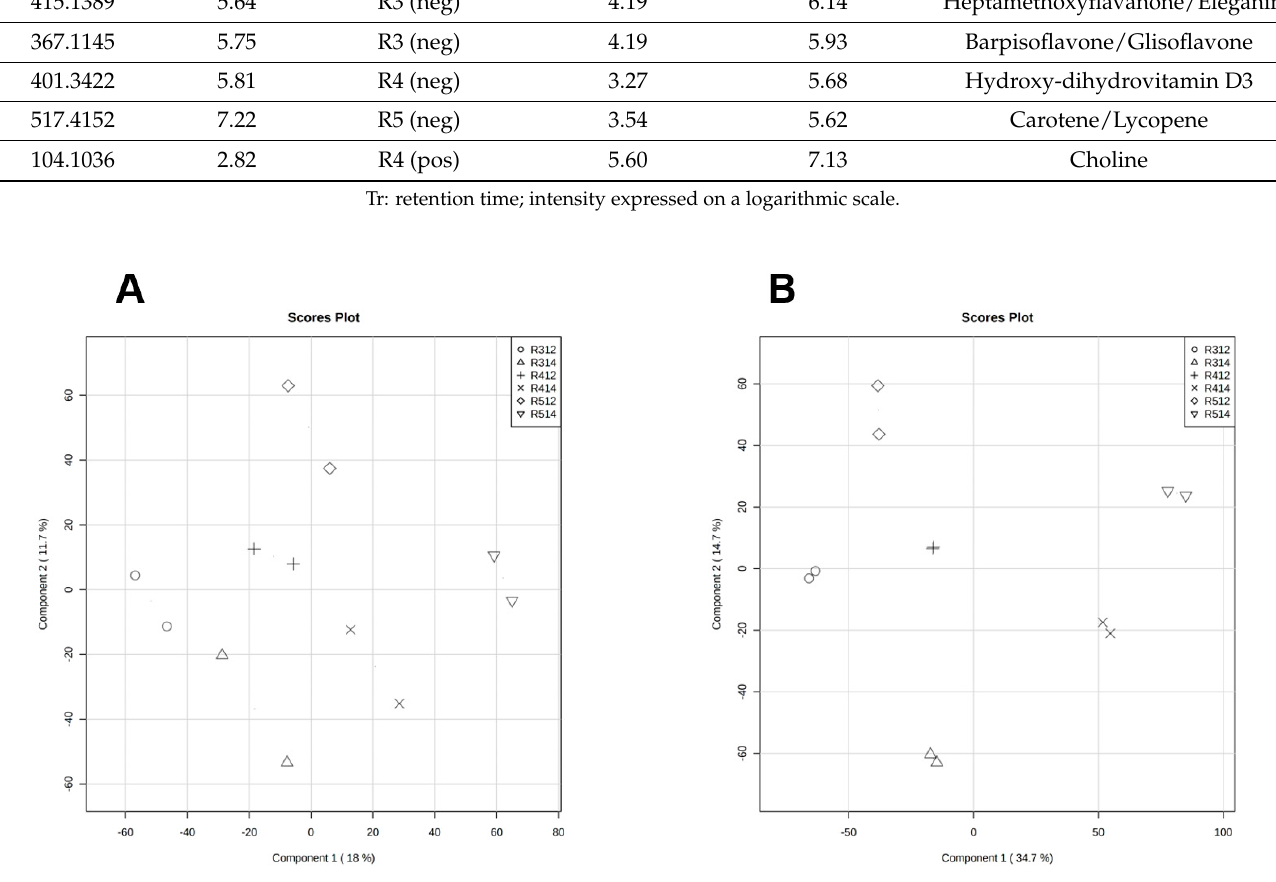
Figure 4. Representation the PLS-DA Score Plots obtained in the comparisons among all groups in positive ( A ) and in negative ( B ) polarity.